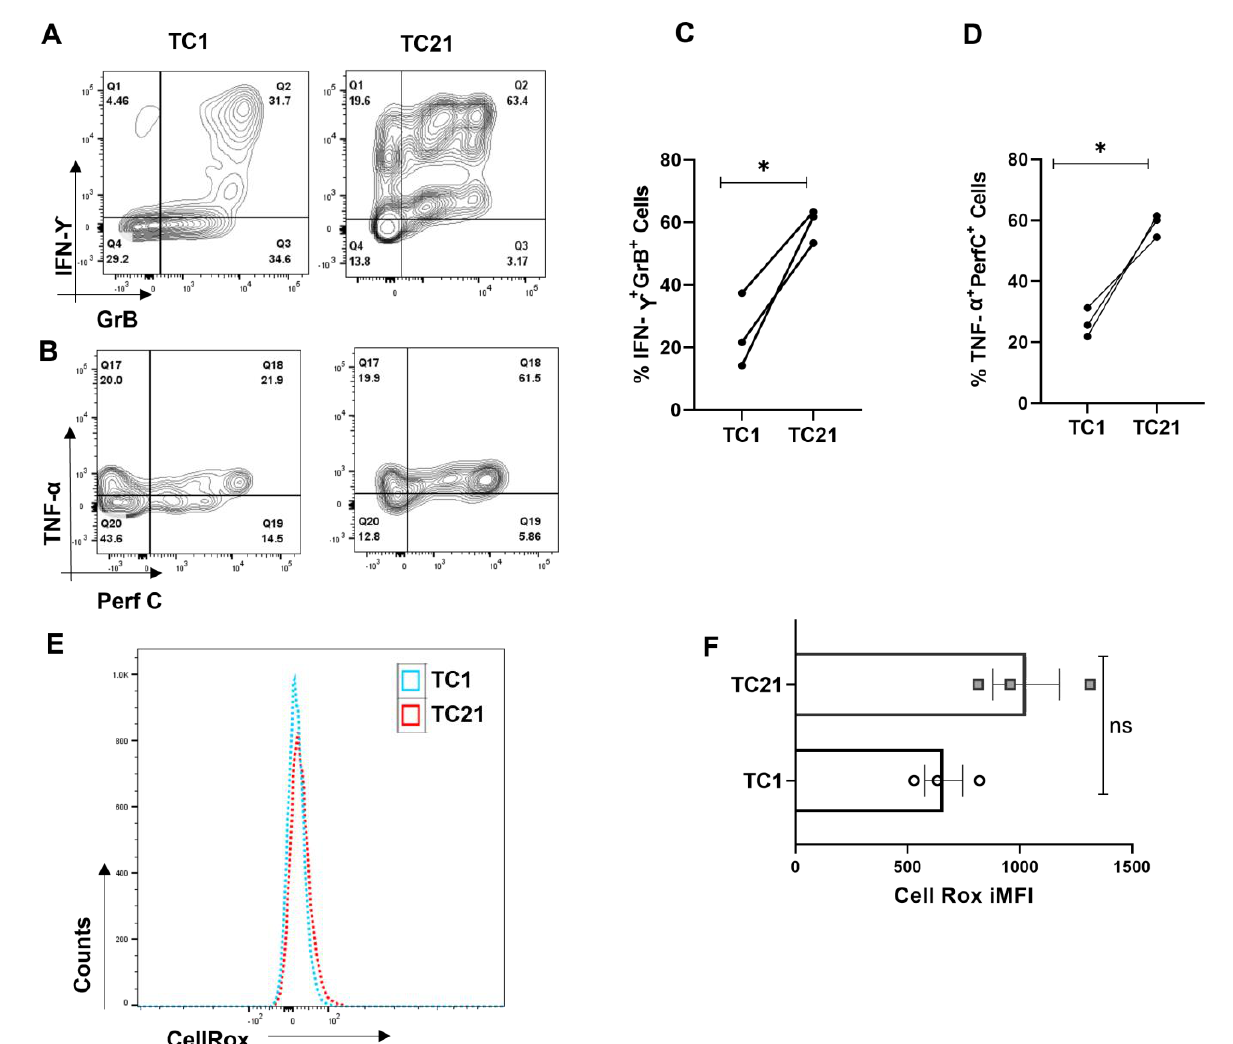
Figure 8. IL-21 drives hyper-cytotoxicity in Tc1 cells. CD8 + T cells were isolated from healthy controls ( n = 3) and cultured for 10 days with and without IL-21 and assessed for different cytokines. Representative flow cytometry figures showing increase in dual positive IFN − γ and Granzyme − B and dual positive TNF − α and Perf − C when IL − 21 is added to the Tc1 culture ( A , B ) and cumulative graphical data showing the same ( C , D ). Representative figure showing cellular ROS in Tc1 and Tc21 ( E ) and cumulative graphical data showing the same ( F ). Error bar indicates SEM. All samples were tested for significance by paired t test (two-tailed) for Tc1 and Tc21cells. Mann–Whitney U test has been used to compare the groups. p < 0.05 was considered statistically significant (*); ns means